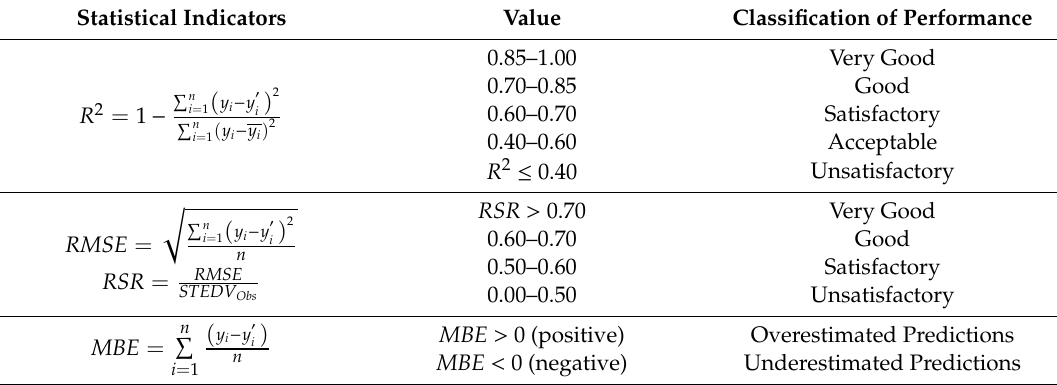
Table 3. Classifications and criteria of the performance for evaluating the linear regression model. Statistical Indicators Value Classification of Performance